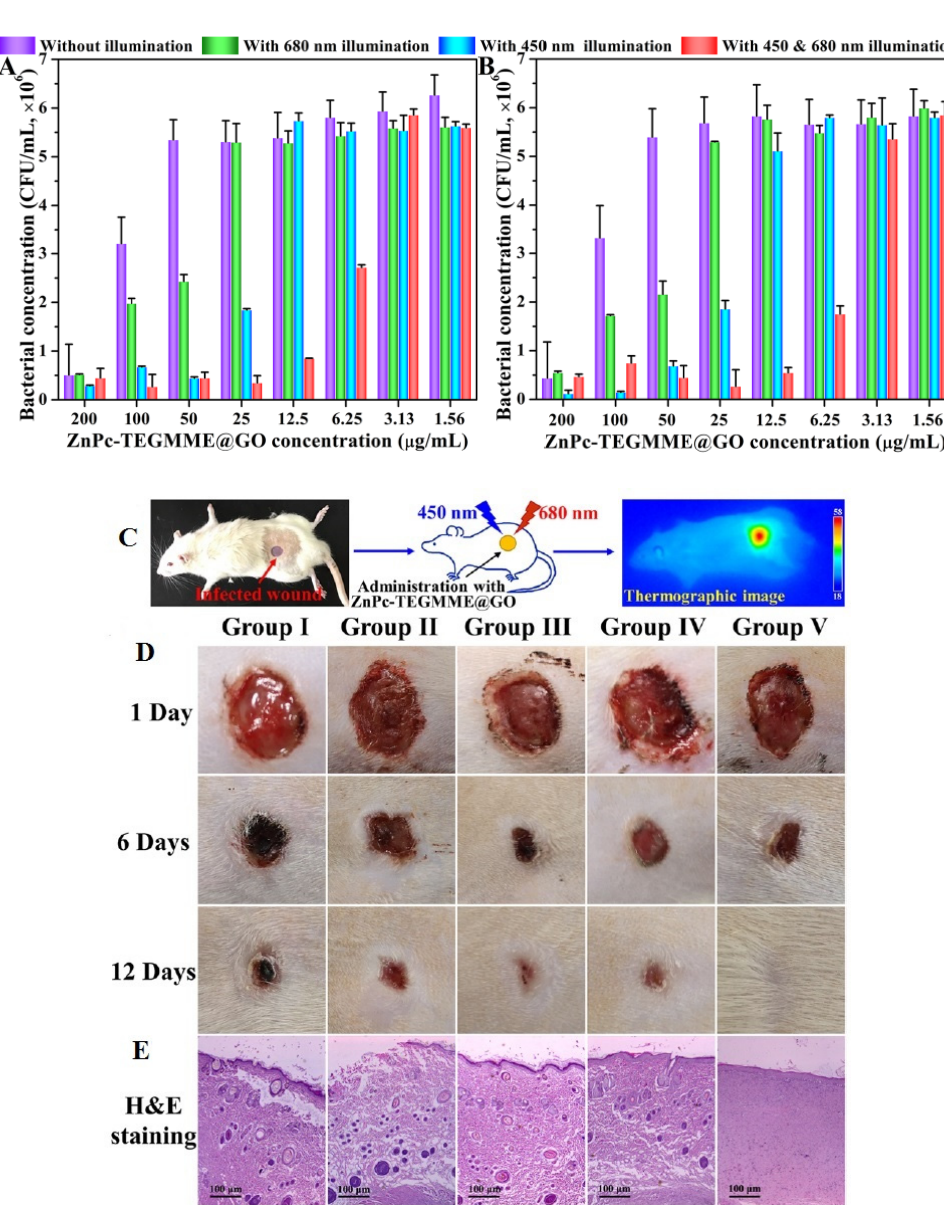
Figure 13. ( A , B ) for S. aureus and E. coli antibacterial activity with ZnPc-TEGMME@GO at different lasers (450 nm and 680 nm) triggered combined PTT/PDT. ( C ) In vivo antibacterial activity to infected mice treated with ZnPc-TEGMME@GO and its thermographic images. ( D ) Infected wound area before and after PT from Day 1 to day 12 represented in five groups. Group I with saline water and dark. Group II is ZnPc-TEGMME@GO and dark. Group III is ZnPc-TEGMME@GO 680 nm laser. Group IV is for ZnPc-TEGMME@GO and 450 nm lasers and finally Group V is for ZnPc-TEGMME@GO with 680 nm and 450 nm laser. ( E ) H&E (Hematoxylin and Eosin) Staining [76]. Reprinted/adapted with permission from Ref. [76]. Copy right 2021, copyright ACS 2021.